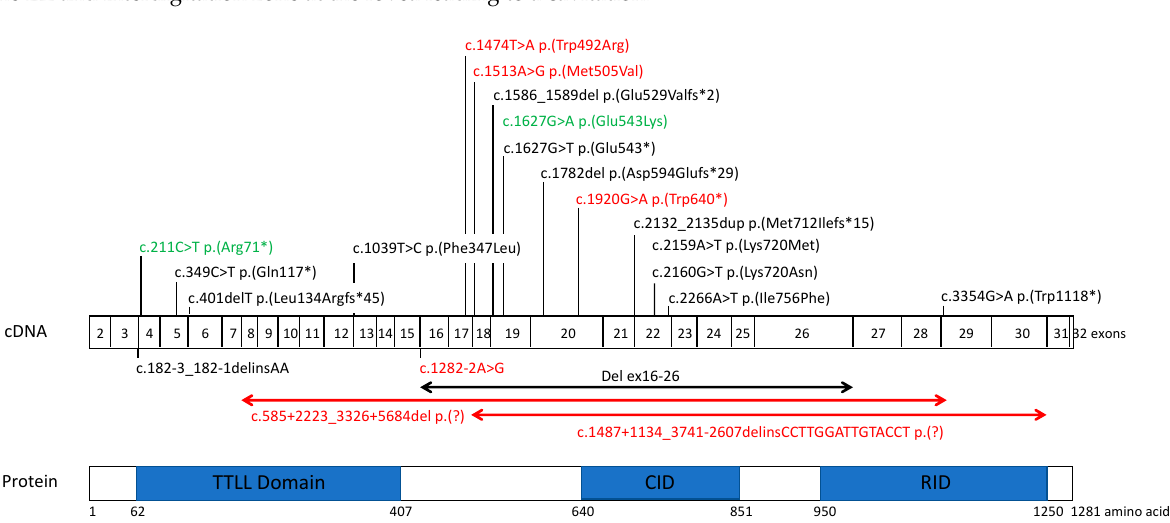
Figure 2. Localization of all reported and novel TTLL5 variants in cone and cone-rod dystrophies. Novel variations are in red, previously reported variants are in black and variants previously reported found in this study are in green. cDNA and protein (if known) nomenclatures are reported for each variant. TTLL5 is composed of 32 exons (depicted as boxes) and encodes 1281 amino acids. Protein domains, presented in blue boxes in the lower part, are as follows: TTLL core domain (delineated from amino acid 62 to 407) has a role in side chain elongation activity and in initiating the side chain, and polyglutamylation activity requires addition sequences of 100–150 amino acids on either side of the core TTL domain for full activity; c-MTBD (cationic microtubule binding domain) (amino acids 378 to 488); CID (cofactor interaction domain) (amino acids 640 to 841); RID (receptor interaction domain) has an unknown function, a C-terminal extension, and is required for transcription factor activity.